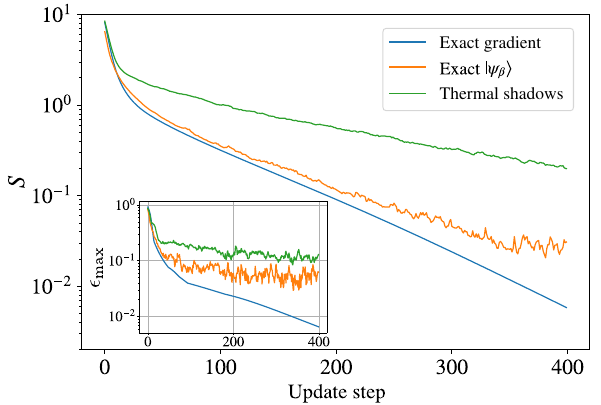
FIG. 3. The quantum relative entropy, S (η (cid:11) ρ β ) , versus the gradient-descent update step. The three curves are for three different methods with which the required Gibbs-state expec- tation values in the gradient are computed. The inset shows the maximum error between the expectation values of the tar- get density matrix and the QBM, (cid:6) max ≡ max j |(cid:3) O j (cid:2) ρ as a function of the update step. For these simulations, we use 5000 thermal (Pauli) shadows, a polynomial degree of 32, and a learning rate of